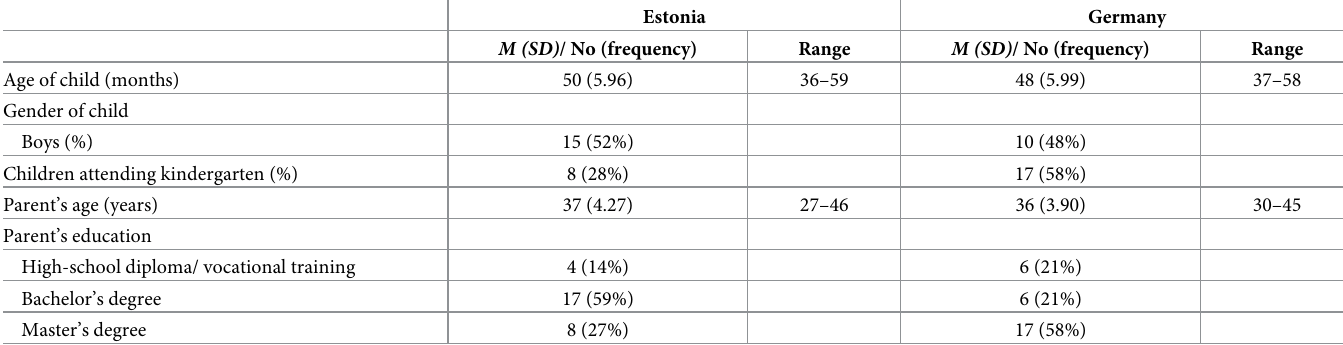
Table 1. Participants’ demographic